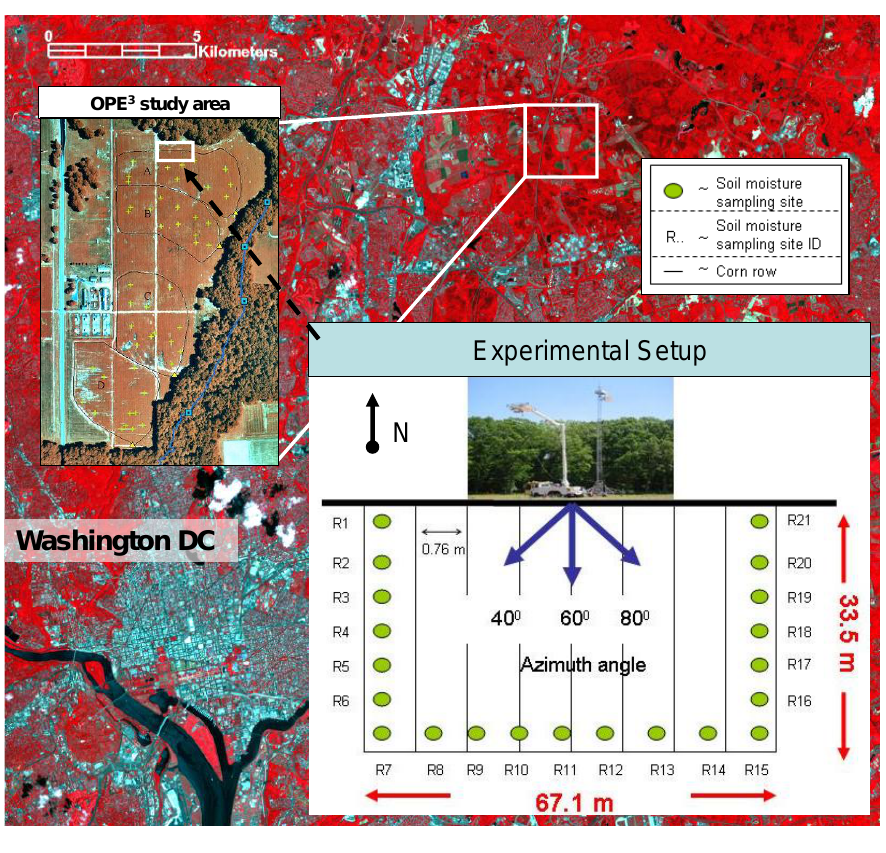
Figure 1. Location and schematization of the OPE 3 remote sensing experimental setup in